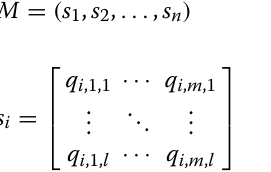
[22–26] while hashing has been proven an effective data protection technology. Please note that the sport score records are time-aware as exampled in Fig. 1. There- fore, to smooth the subsequent sport index creation and assignment procedure, we first model the time- aware sport score records with the sport-time-score matrix M in Eqs. (1)-(2). Here, we assume there are n { s 1 , s 2 , . . . , s n } , m kinds of sport students, i.e., Stu _ set = items, i.e., SI _ set = { si 1 , . . . , si m } and l time slots, i.e., T _ set = { t 1 , . . . , t l } . Thus, each column in matrix M in Eq. (1) denotes a student in Stu _ set , each row of s i in Eq. (2) indicates a time slot and each column of s i in Eq. (2) rep- resents a sport item. With the above formulation, we can find that each entry q i , j , k ( 1 ≤ i ≤ n , 1 ≤ j ≤ m , 1 ≤ k ≤ l ) ′ s score of sport item si j at time in Eq. (2) means student s i slot t k , which has been exampled in Fig. 1.